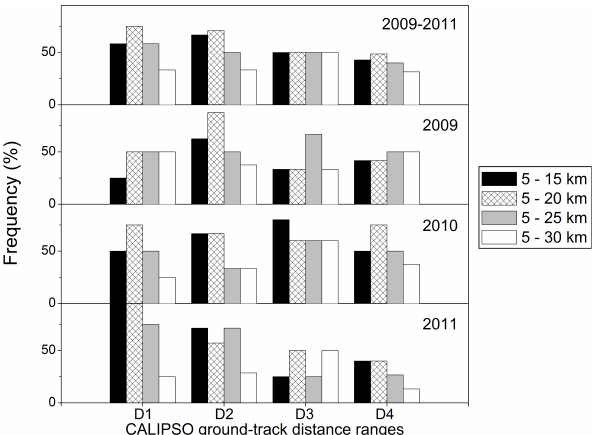
Fig. 6. Mean differences ( 1 = δ MPL − δ CAL ) (open symbols, left) and their RMS values (solid line, right) for the four predominant CALIPSO ground-track distance ranges (from left to right, and from top to bottom, respectively): < 10km (D1), 20–30km (D2), 45– 55km (D3) and 70–90km (D4). 5-km averaged mean differences (black stars, with their SD errors) are also